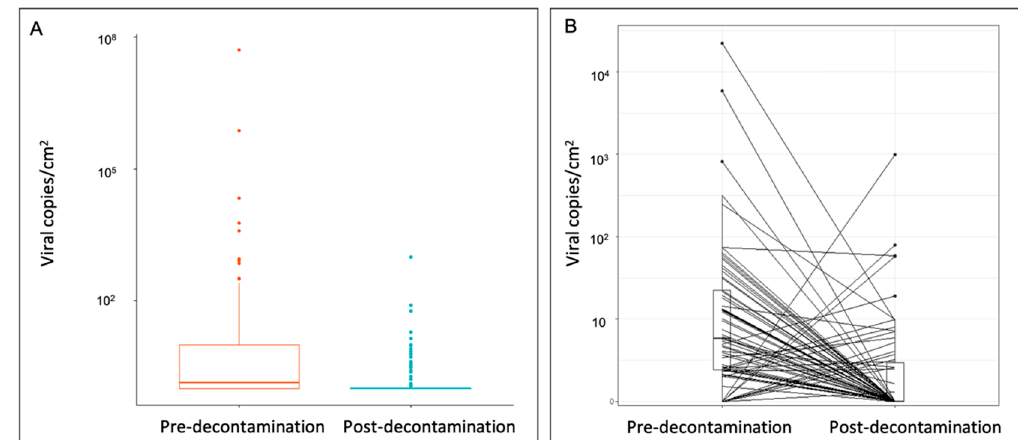
Figure 2. Quantification of SARS-CoV-2 surface distribution on ( A ) all sampled objects and ( B ) matched sampled objects pre- and post-decontamination. Wilcoxon signed-rank test on matched samples ( p < 0.0001). SARS-CoV-2, severe acute respiratory syndrome coronavirus 2. Table 2. Quantitative Distribution of SARS-CoV-2–Positive Fomites Pre- and Post-Chemical Decon- tamination.